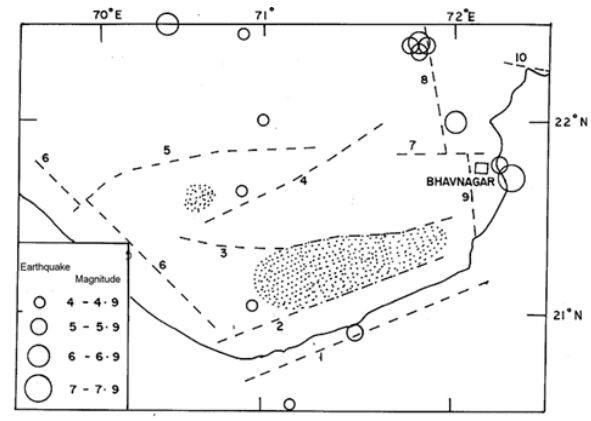
Fig. 3. Location of past earthquakes of magnitude 4 and above. (Note: Dotted areas are dyke zones of swarms. Faults are shown by dashed lines. 1, South Saurashtra fault; 2, Rajula fault; 3, Saverkun- dala fault; 4, South Junagadh fault; 5, North Junagadh fault; 6, Um- rethi fault; 7, Shihor fault; 8, West Cambay basin fault; 9, Eastward offsetted West Cam- bay basin fault, and 10, Camay–Dabhoi fault.) (Bhattacharya et al.,